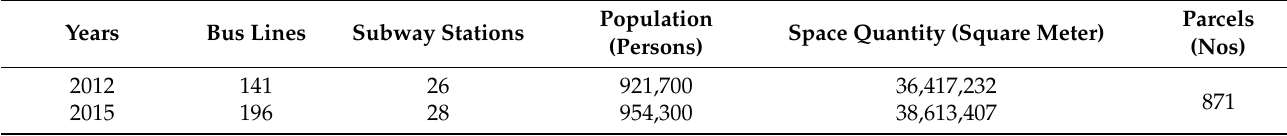
Table 1. Type study data of Jiang’an